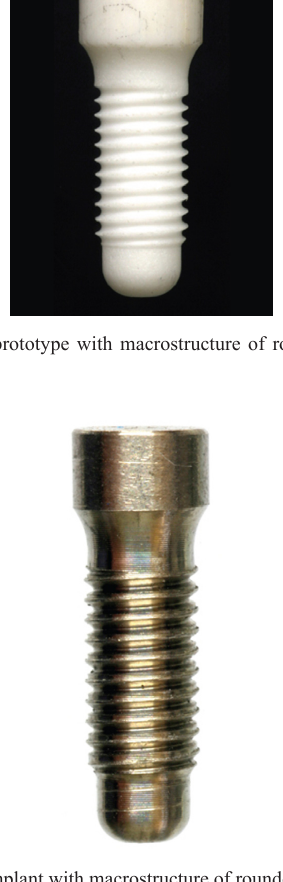
Figure 2. Ti implant with macrostructure of rounded tip and apex profile equal to Zr implant.